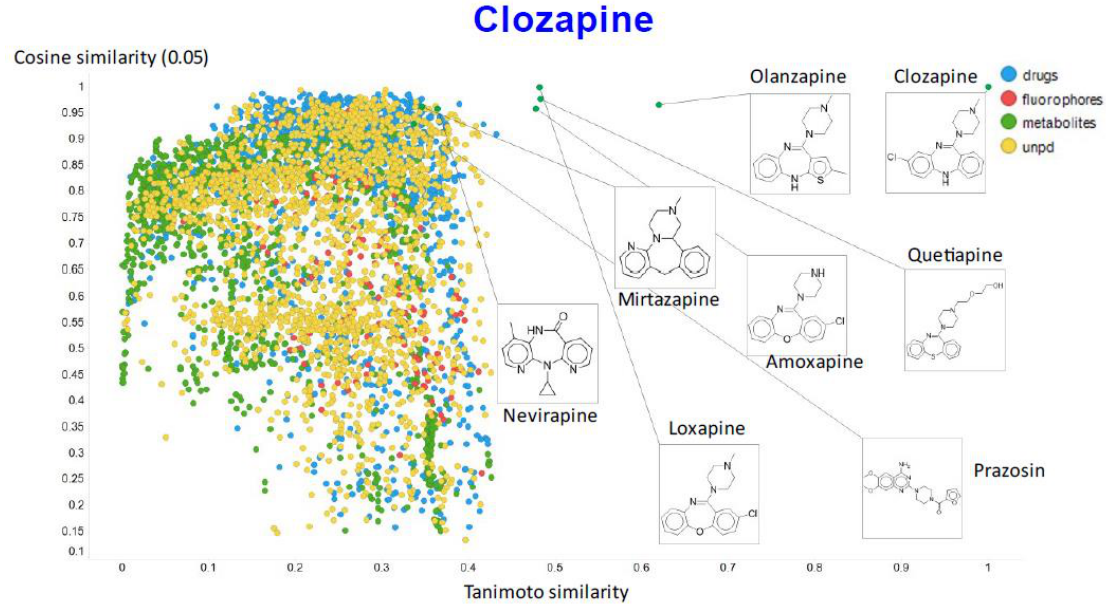
Figure 9. Relationship between cosine similarity and Tanimoto similarity for clozapine in our chemical space, using a temperature of 0.05.